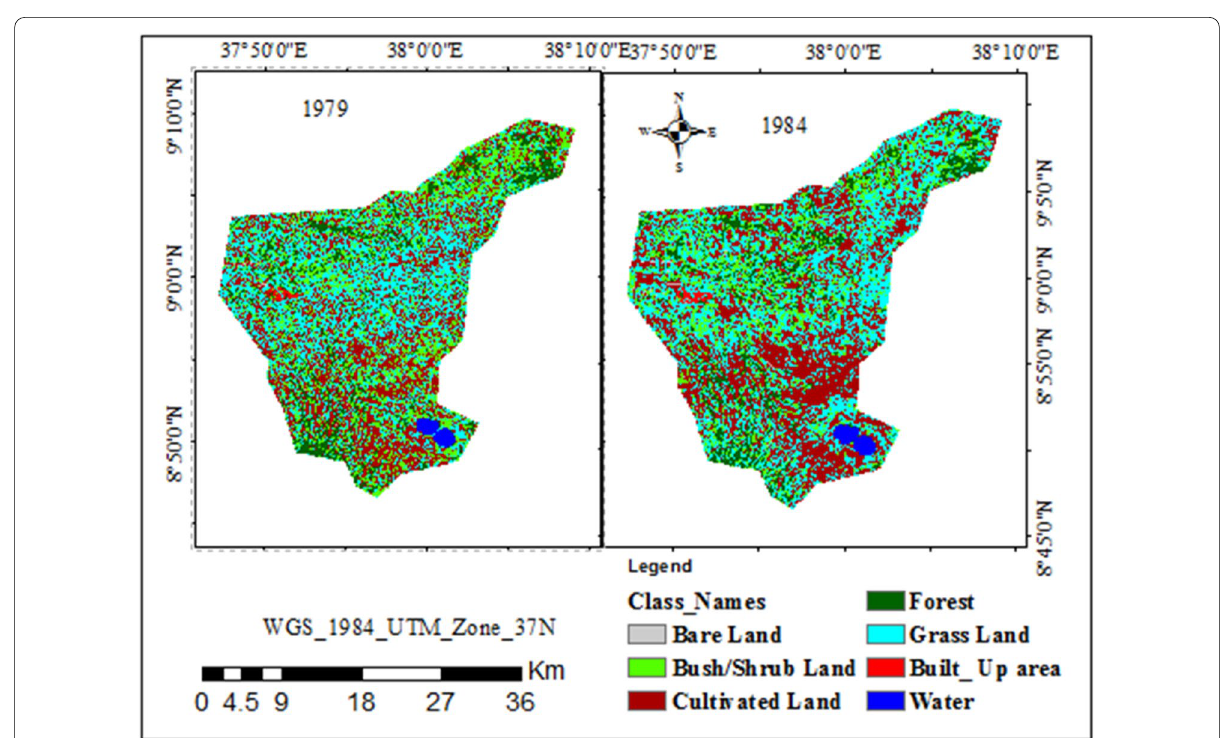
Fig. 4 Land use and land cover Maps of Huluka Watershed for 1979 and